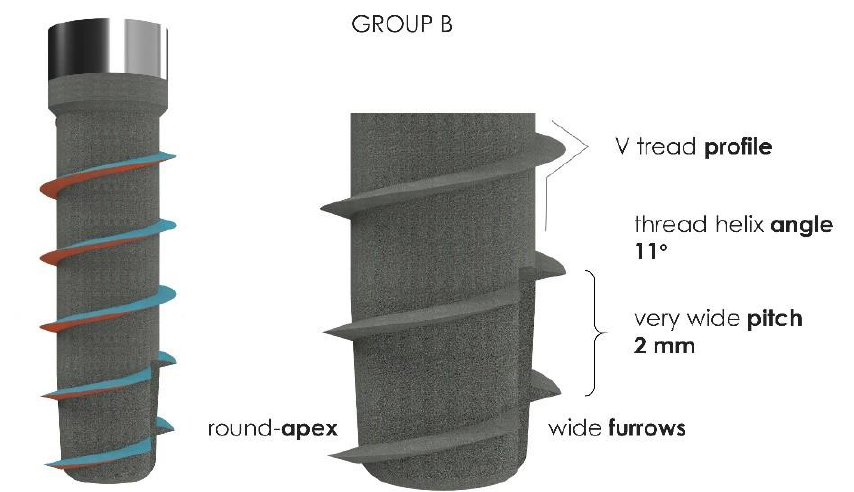
Figure 2. Group B: in detail, the morphology and long-thread geometry of the cylindrical implants.